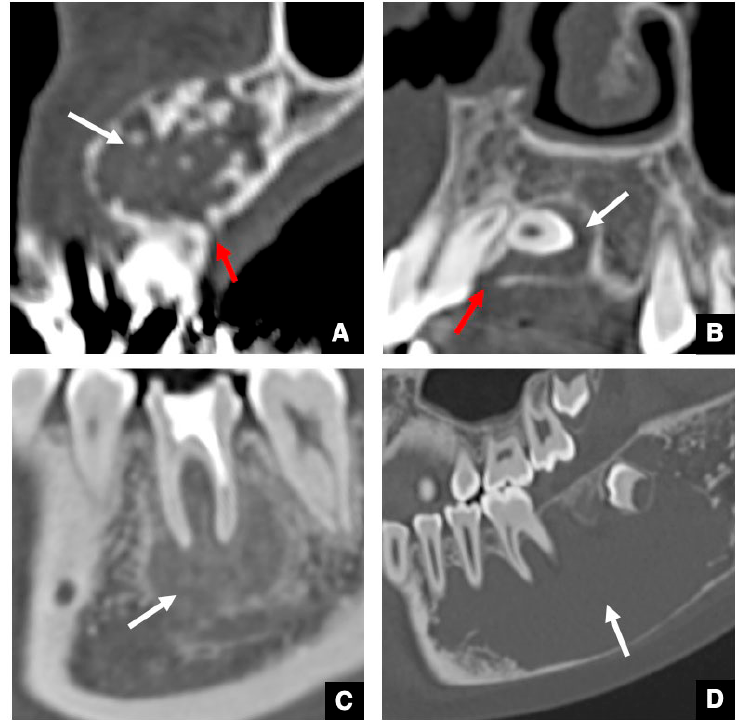
Figure 7. Difference in GTs between odontogenic and non-odontogenic masses. ( A ) The GT (red arrow) continues to the top of the ameloblastoma (arrow) as the representative odontogenic tumor. ( B ) An almost intact GT (red arrow) continues to the top of the dentigerous cyst (arrow) as the representative odontogenic cyst. ( C ) The GT at the top of the alveolar bone is not detected in an ossifying fibroma (arrow) as the representative non-odontogenic tumor. ( D ) The GT at the top of the alveolar bone is not detected in a simple bone cyst (arrow) as the representative non-odontogenic cyst.